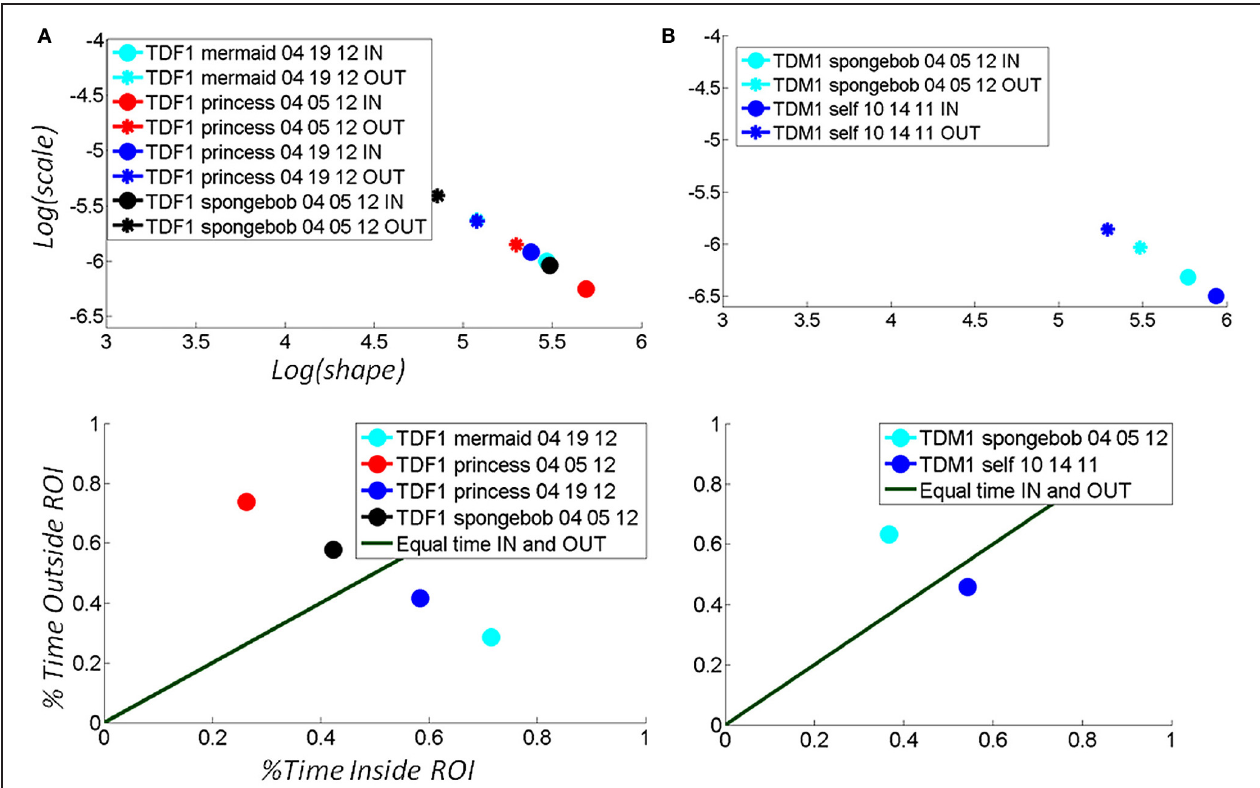
SquarePants” video, demonstrated by the stochastic patterns of angular velocity micro-movements shifting to more systematic regimes for the former rather than the latter. Likewise, we longitudinally quantified improvements over the course of a week using the preferred media (from red to cyan). (B) A TD male prefers the real-time video of himself to the “SpongeBob SquarePants” videos. He spends over 50% of the time in the vRoI for the former media, deliberately holding his hand to watch himself, and over 60% of the time outside the vRoI exploring during SpongeBob. In the top panel, the patterns inside the vRoI can be seen to be consistently more predictive as they fall farther to the right of the Gamma plane than those outside the vRoI during random